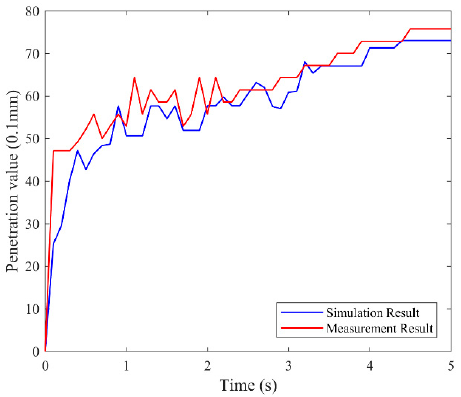
Figure 9. Comparison of simulation result and measurement result.